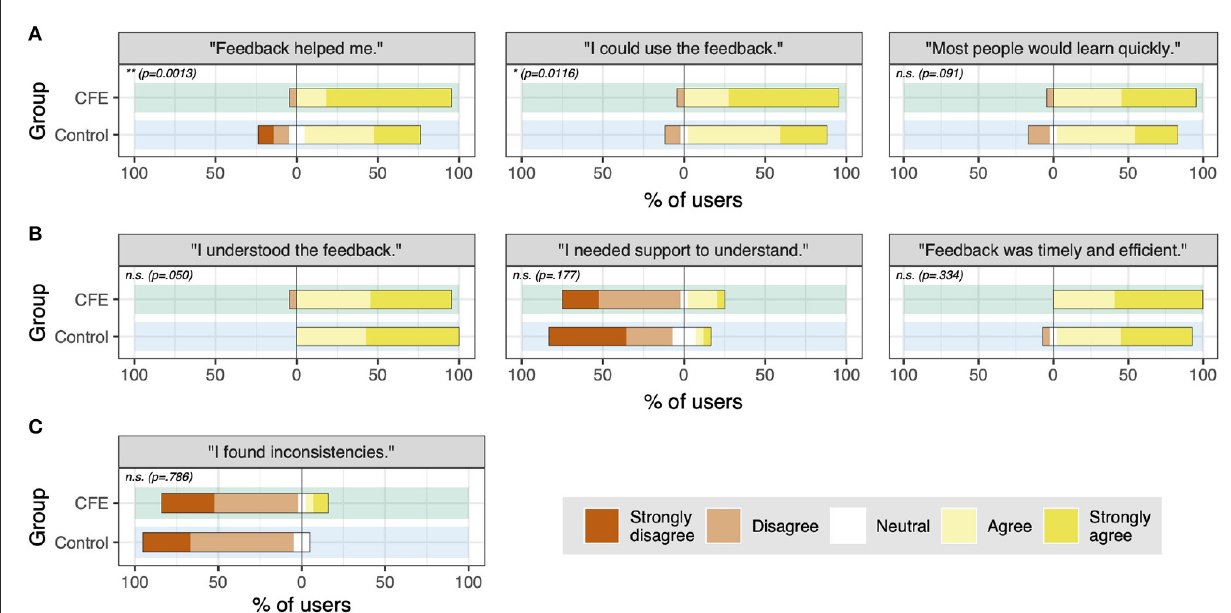
FIGURE8 Experiment 2: Overview of user responses in post-game survey (adapted from Holzinger et al., 2020) per group. (A) Depicts user replies in survey items relevant for hypothesis 2, (B) depicts user replies in survey items relevant for hypothesis 3, and (C) depicts replies relevant for our last exploratory analysis. Statistical information including the respective p -value is given within each item’s box (n.s., not